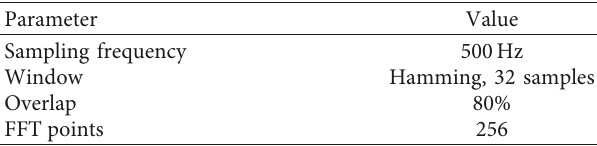
Figure 3: Spectrogram of input data. Table 1: Spectrogram